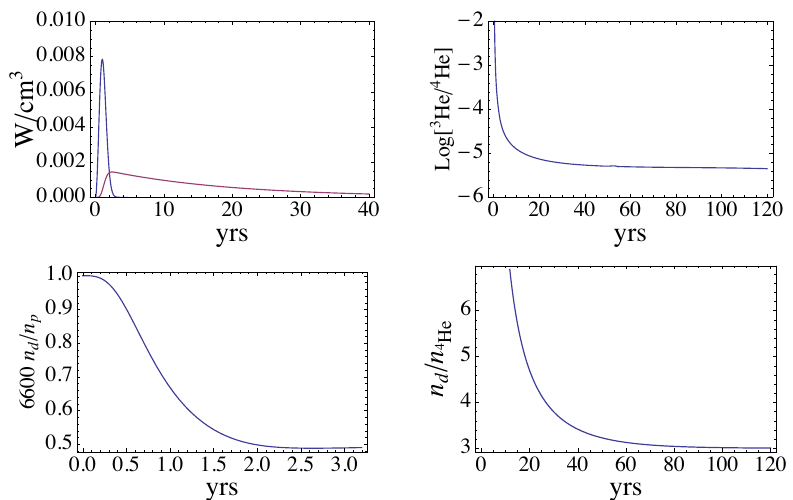
Fig. 6. Upper left panel: the proton tresino formation power (the fast “spike”) and the much slower nuclear reaction power (presented here multiplied by a factor of 10 for graphical clarity). Upper right panel: the log of ratio 3 He / 4 He. Lower left panel: the log of the ratio 6600 n d /n p in the early time. Lower right panel: the ratio of initial deuteron density to the 4 He